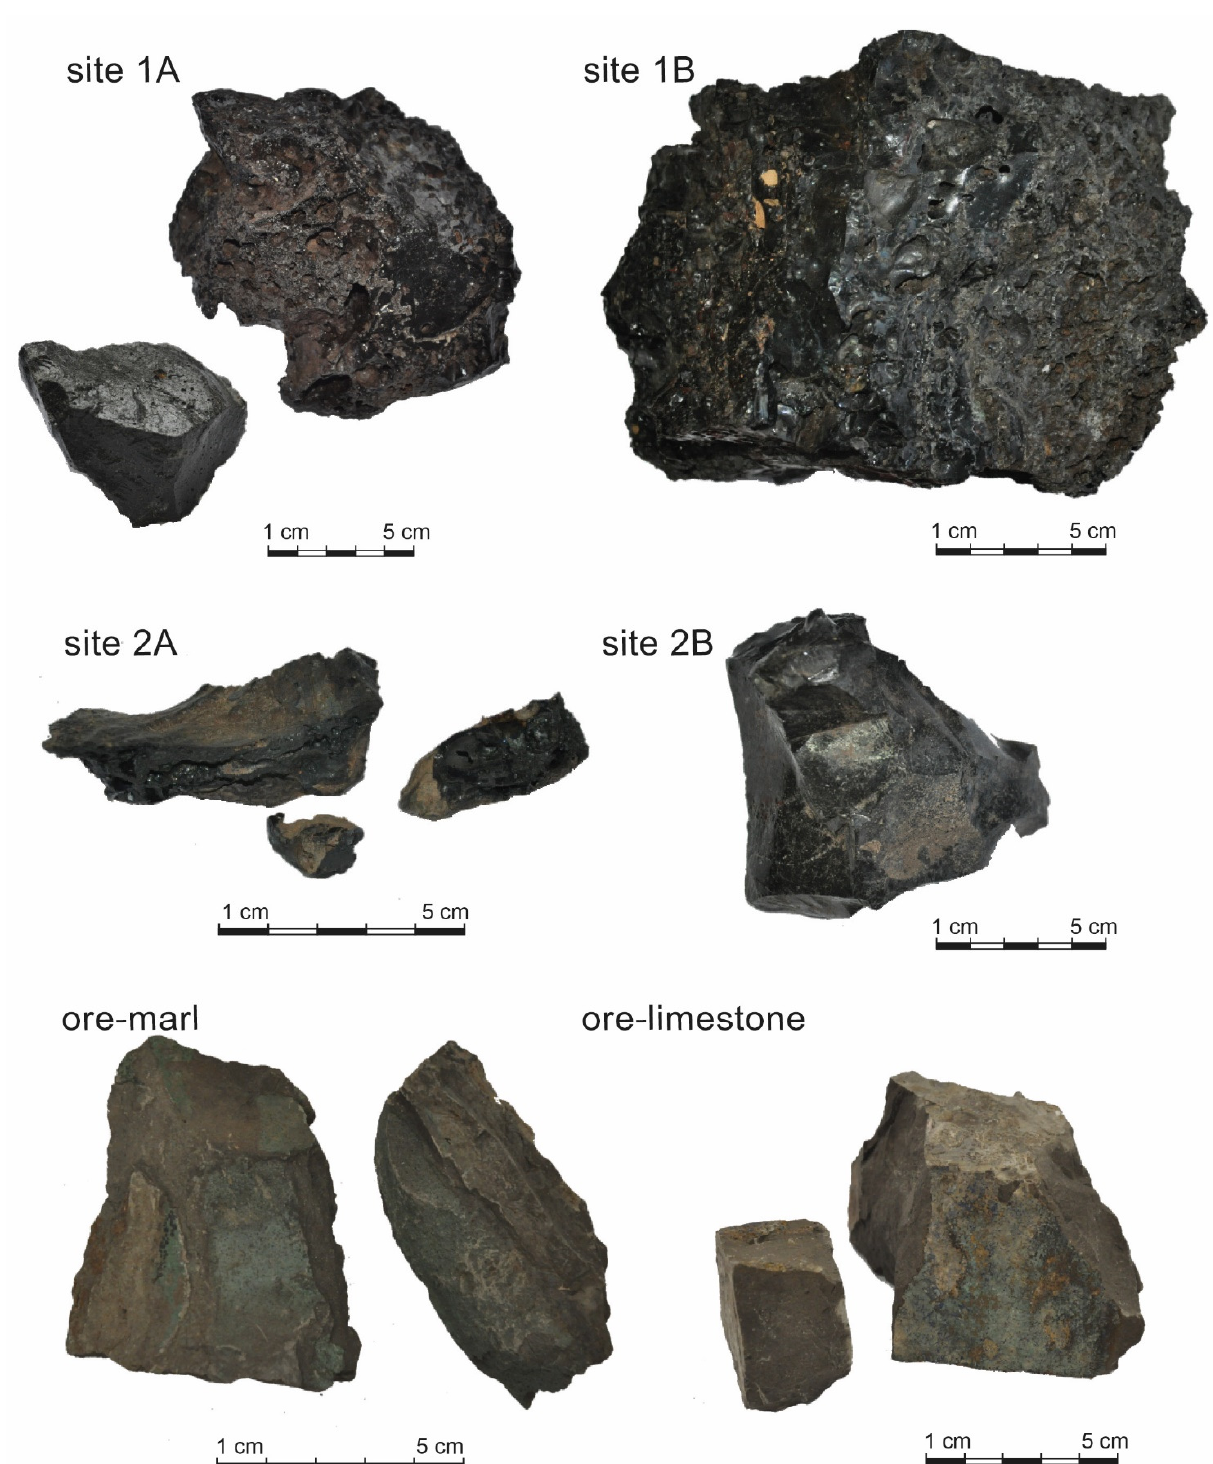
Figure 3. Macroscopic photographs of representative slags from four sites: Site 1A (19th-century smelting), Site 1B (20th-century smelting), Site 2A (18th-century smelting), and Site 2B (19th-century smelting). In the bottom row, two examples of ore-hosting rocks from Leszczyna are presented: Cu-marl and Cu-limestone.